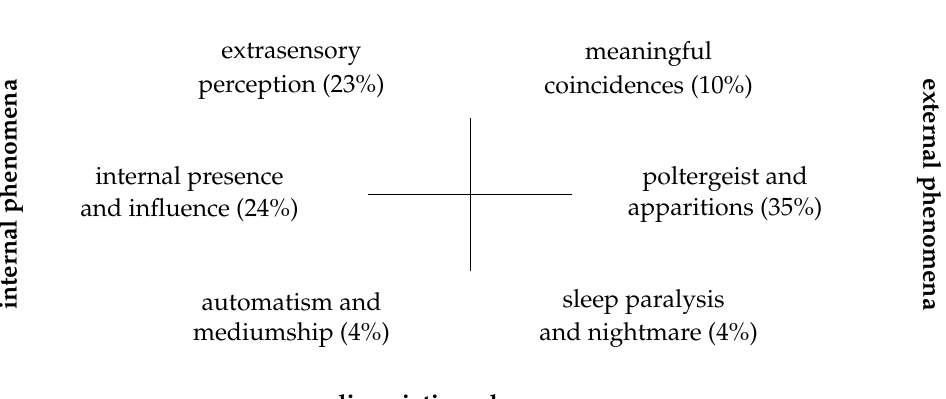
Figure 3. Empirically assessed experience patterns (based on a total of 2356 reports of counseling cases at IGPP that could be assigned to the six EE-patterns) support the classification derived from the conceptual scheme in Sections 4.1 and 4.2. Internal and external phenomena are deviations in the self model and world model, respectively. Coincidence phenomena show connections (excess correlations) of ordinarily disconnected elements of self and world model. Dissociation phenomena show disconections (deficit correlations) of ordinarily connected elements of self and world